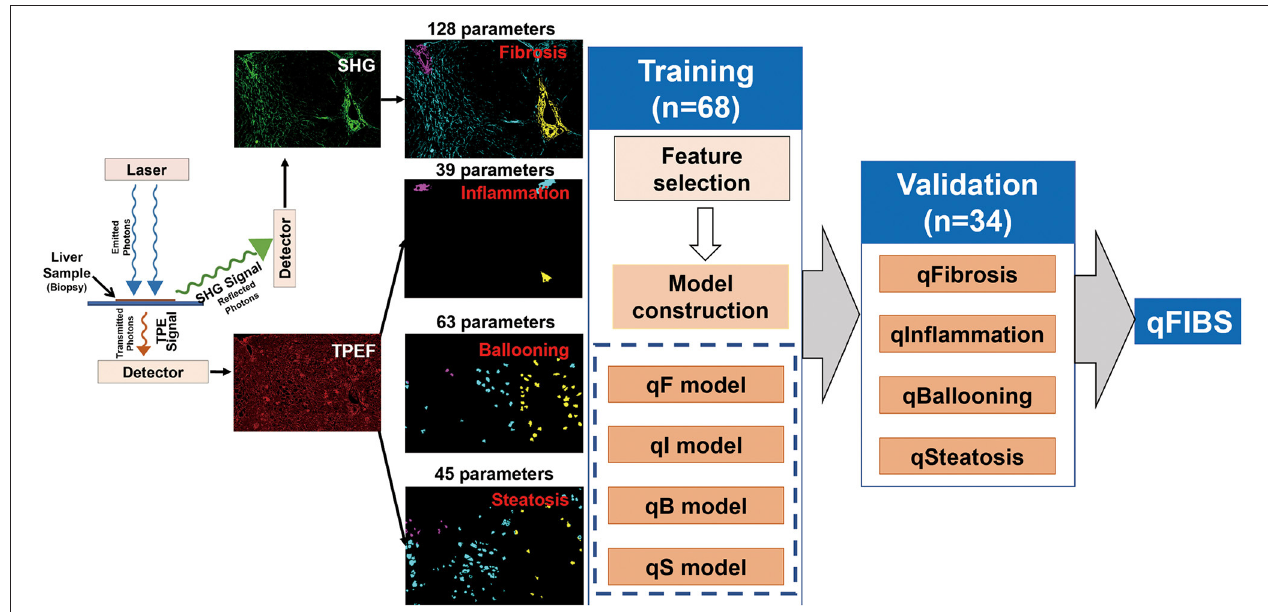
FIGURE 1 | Flowchart shows the steps for the development of the four components of pediatric qFIBS (qFibrosis, qInflammation, qBallooning, and